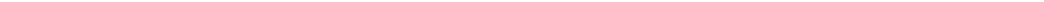
directionality of mutant cells. Error bars in graphs are standard